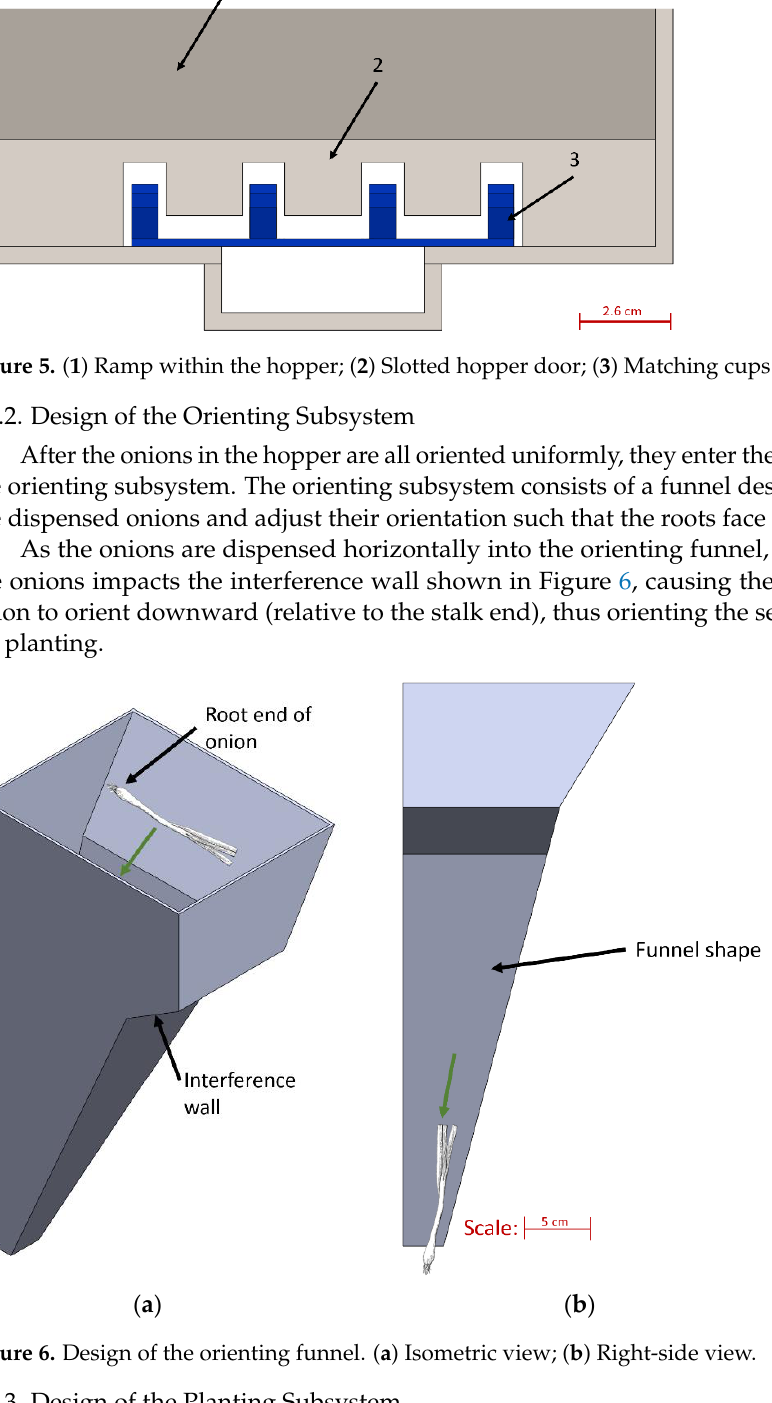
Figure 6. Design of the orienting funnel. ( a ) Isometric view; ( b ) Right-side view.